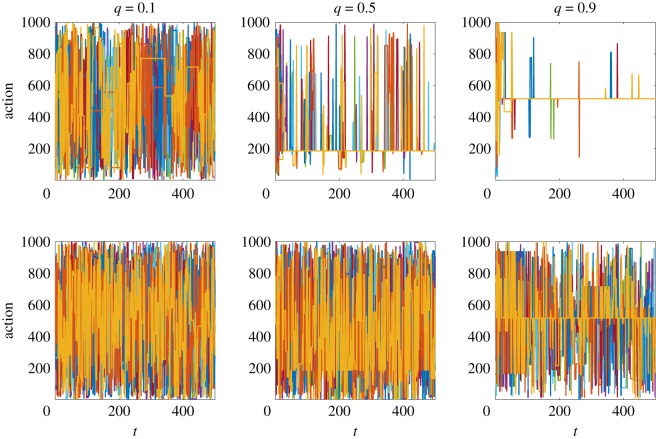
From left to right panels show results of a single simulation run of the model for q = 0.1, q = 0.5 and q = 0.9, respectively. Top (bottom) panels show the trajectories of the top (bottom) 10 agents based on the ranking at the final time T = 500. The y-axis shows the numbers associated with the actions being adopted, which go from 1 to M = 1000 in no particular order. As it can be seen, in the q = 0.5 simulation the top agents tend to lock in on action 186, while in the q = 0.9 top agents lock in on action 516.